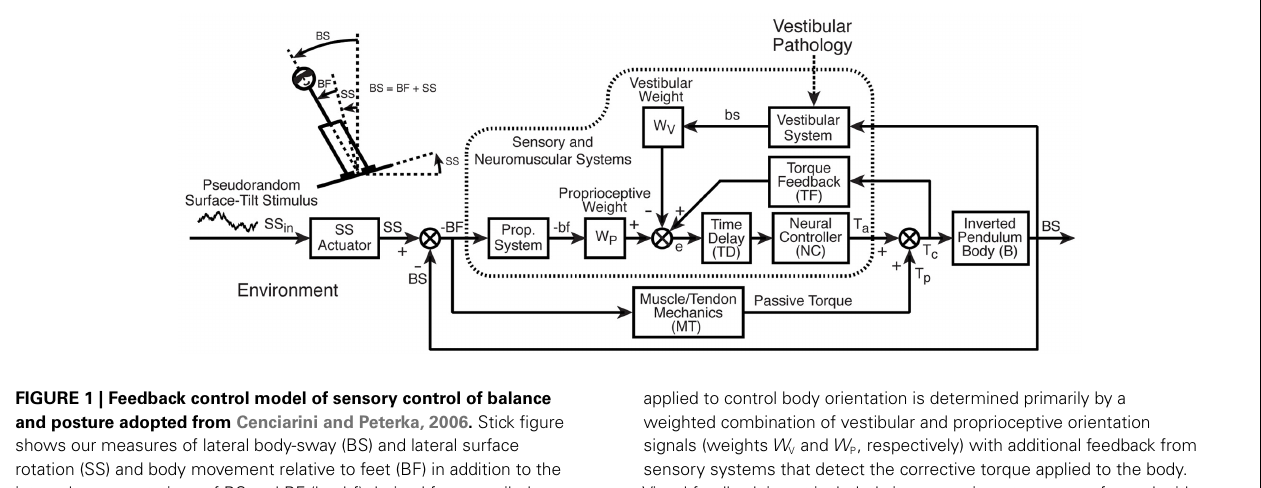
applied to control body orientation is determined primarily by a weighted combination of vestibular and proprioceptive orientation signals (weights W V and W P , respectively) with additional feedback from sensory systems that detect the corrective torque applied to the body. Visual feedback is not included since experiments were performed with eyes-closed. Detailed descriptions of model components are provided in Table 2